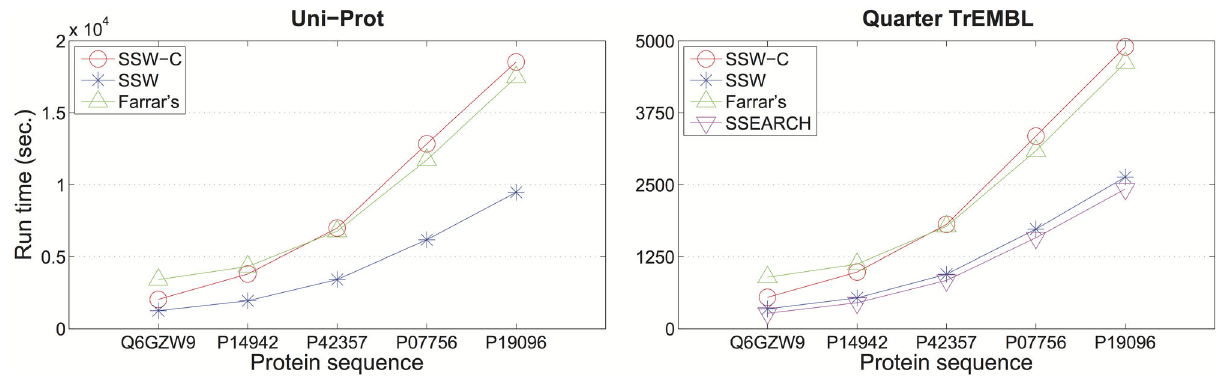
Figure 1. Running time of different SW implementations for protein database search. 5 query proteins were searched against the whole Uni-Prot database (left) and one quarter of the TrEMBL database (right). Running time is shown on the y-axis for SSW without (blue) and with (red) detailed alignment, Farrar’s implementation (green) and SSEARCH (pink). All SW implementations used the BLOSUM50 scoring matrix with gap open penalty -12 and extension penalty -2.